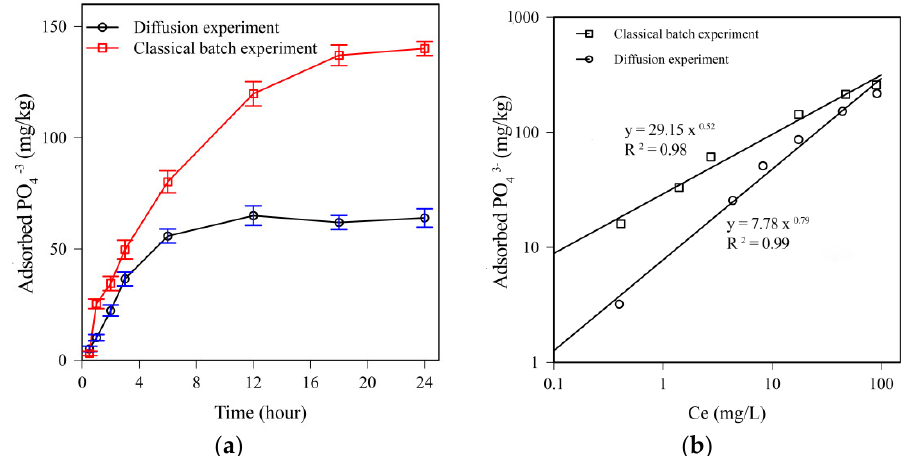
Figure 2. Impact of experimental conditions on adsorbed phosphorous (P) amount and P sorption dynamic. ( a ) Temporal development of adsorbed P amount in classical batch and di ff usion experiment, ( b ) sorption isotherm (Freundlich) from the fine earth obtained from classical batch experiment and di ff usion method (Ce; equilibrium concentration; PO 4 3 − ; phosphate; topsoil).